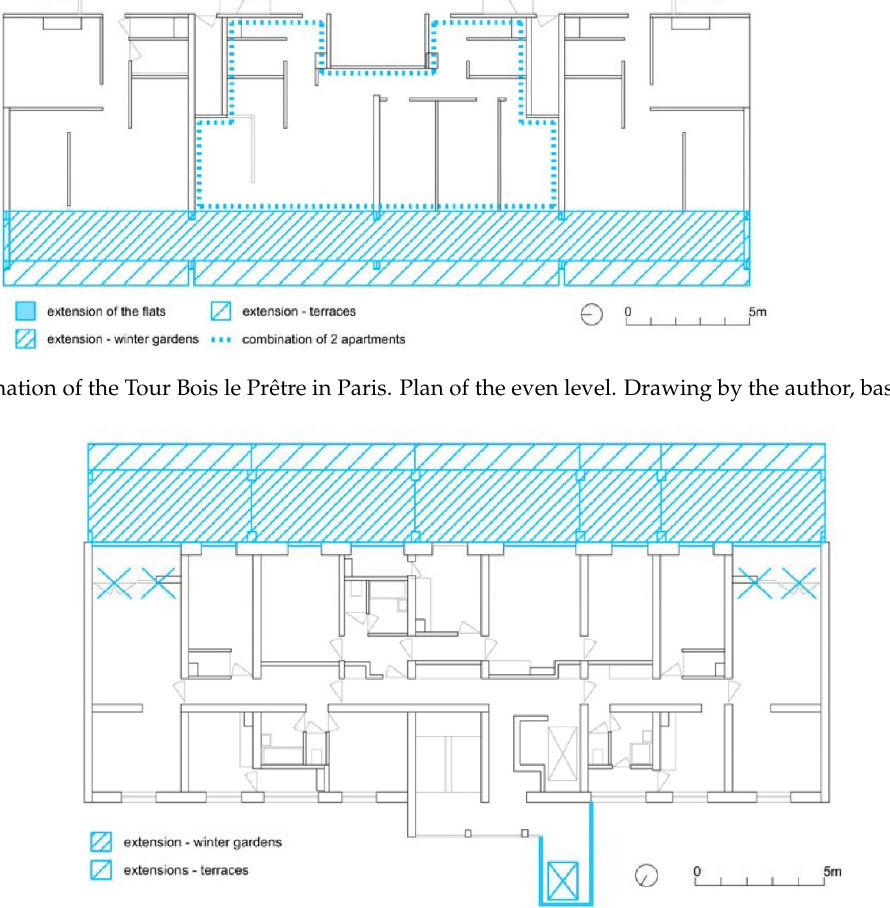
Figure 4. Plan of the part of the buildings H and I in Grand Parc estate after transformation. Drawing by the author, based on [21].